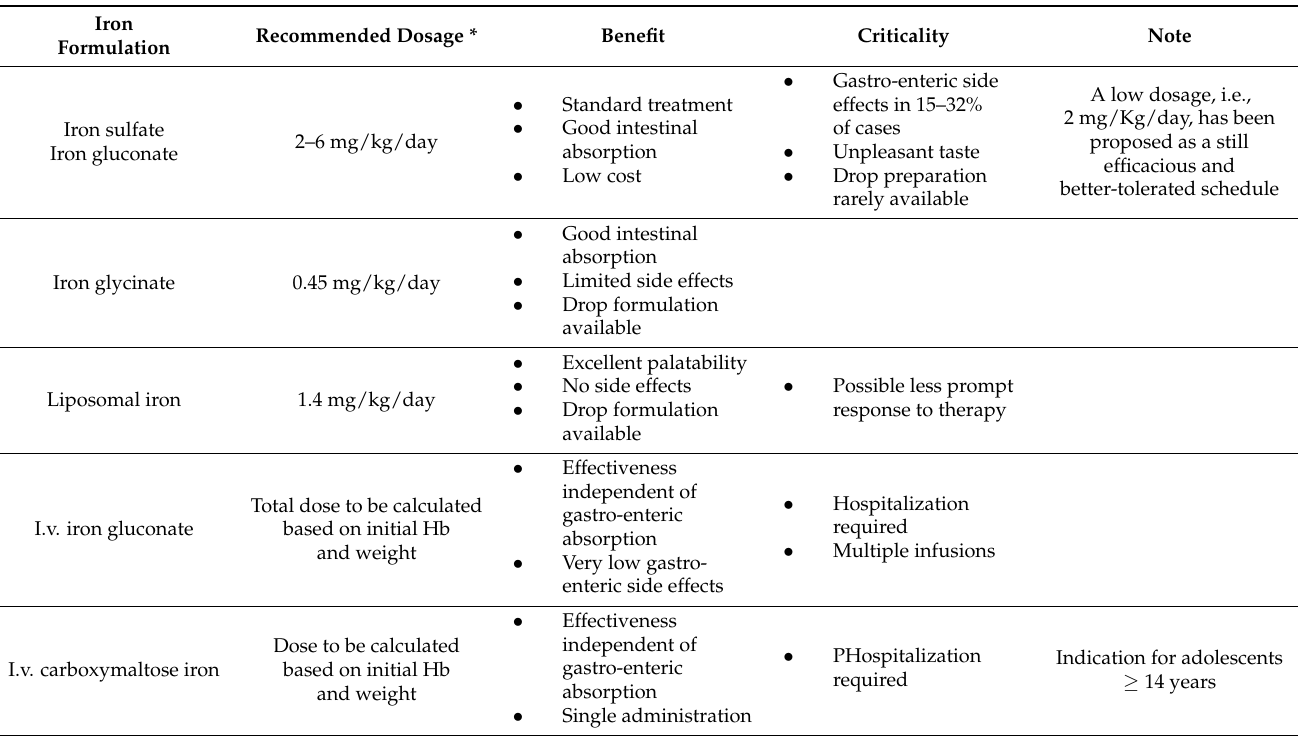
Table 3. Available iron formulations for pediatric